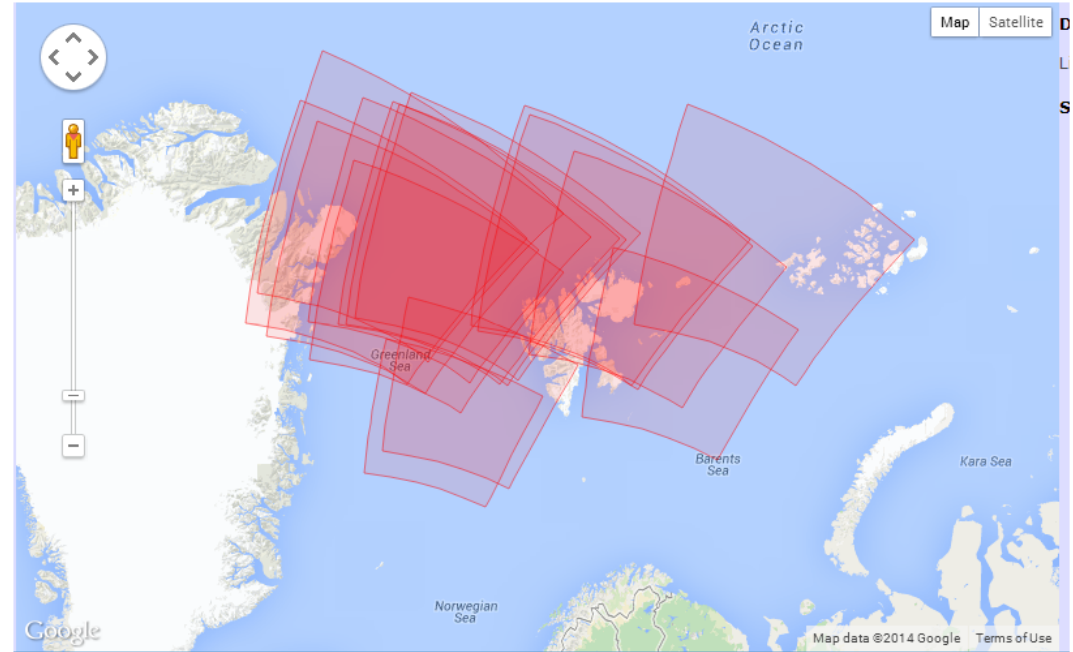
Figure 1. Location of RADARSAT-2 image used for training. All data are provided in GeoTIFF format with auxiliary XML files.